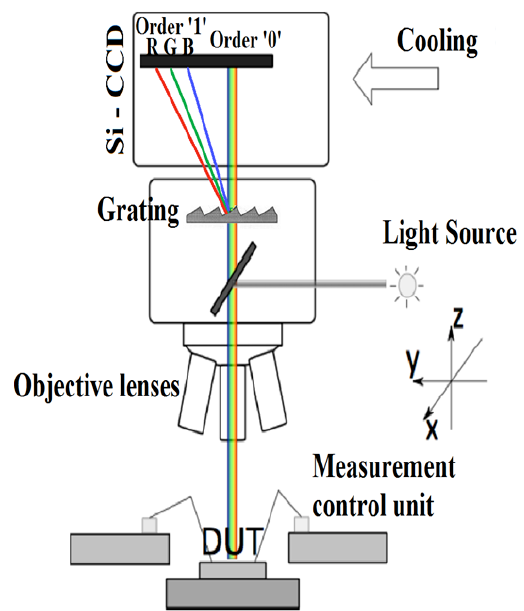
Fig. 5. Insertion of a grating in the optical path of the microscope.